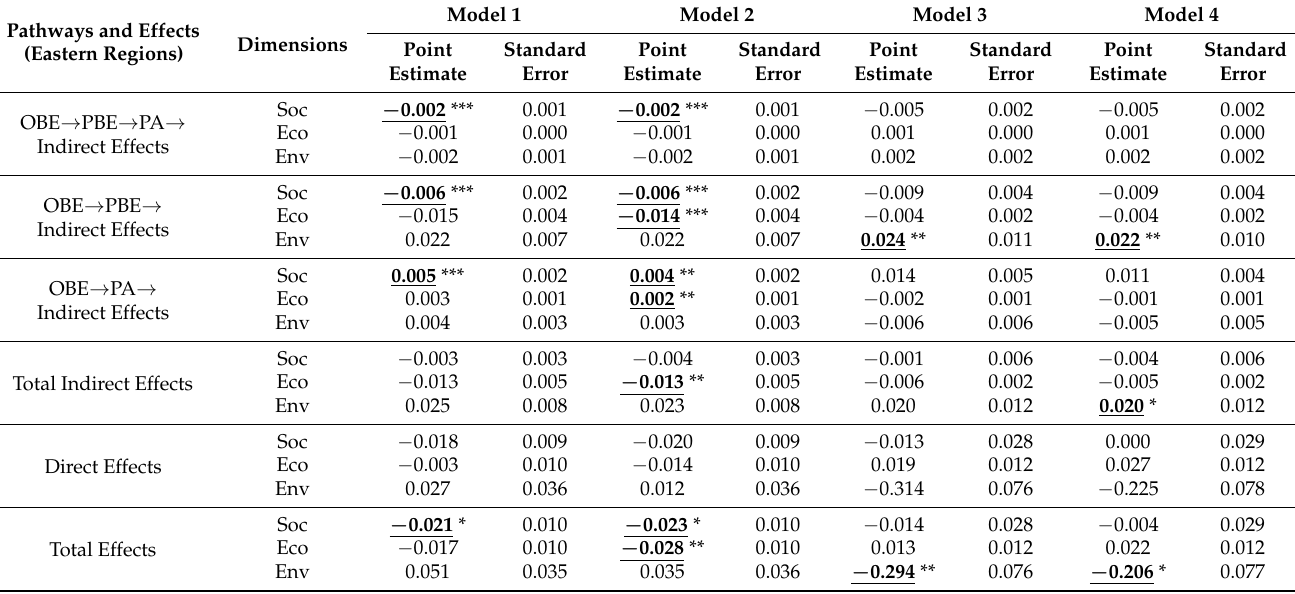
Table 6. Total, direct and indirect effects of OBE on P-RCR (eastern